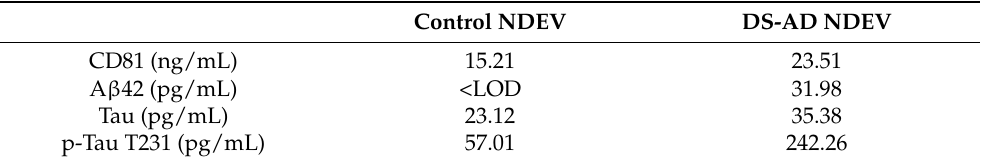
Table 1. Levels of biomarkers measured in NDEV enriched from plasma samples from one partici- pant with DS-AD and one control.